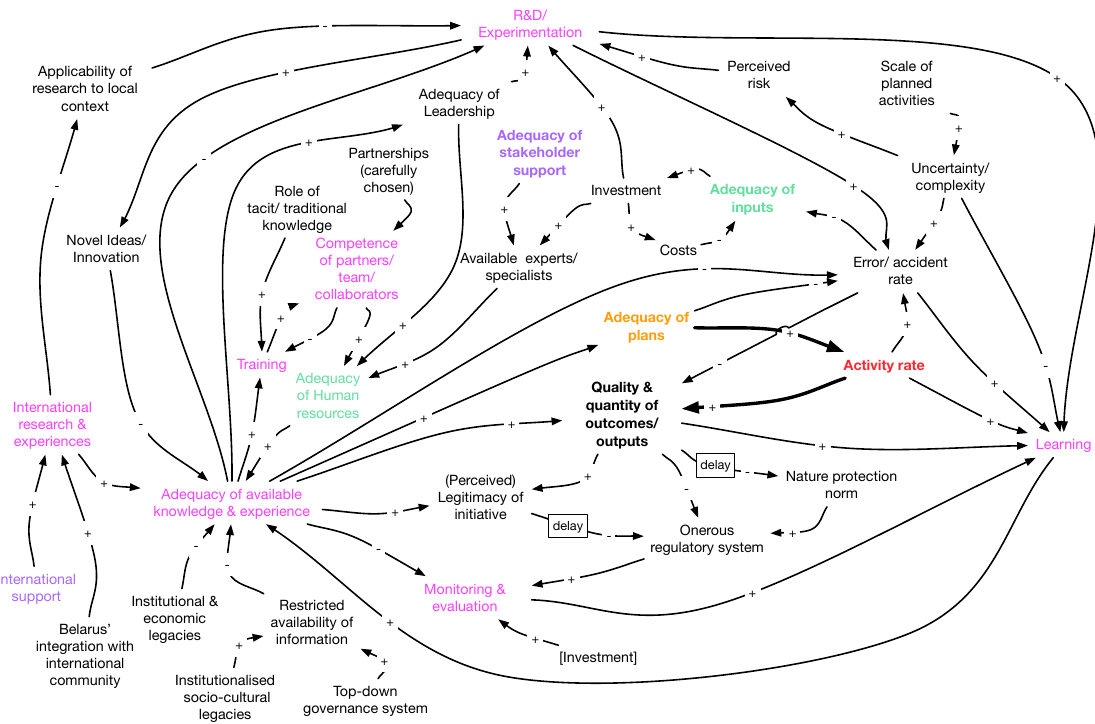
Figure 8 (from main paper). Sub-model unpacking causal dynamics influencing the Adequacy of Learning and Knowledge for wetland restoration initiatives. Learning and knowledge/experience concepts are disaggregated in this sub-model in order to clarify causal pathways. These concepts are otherwise aggregated together in the other